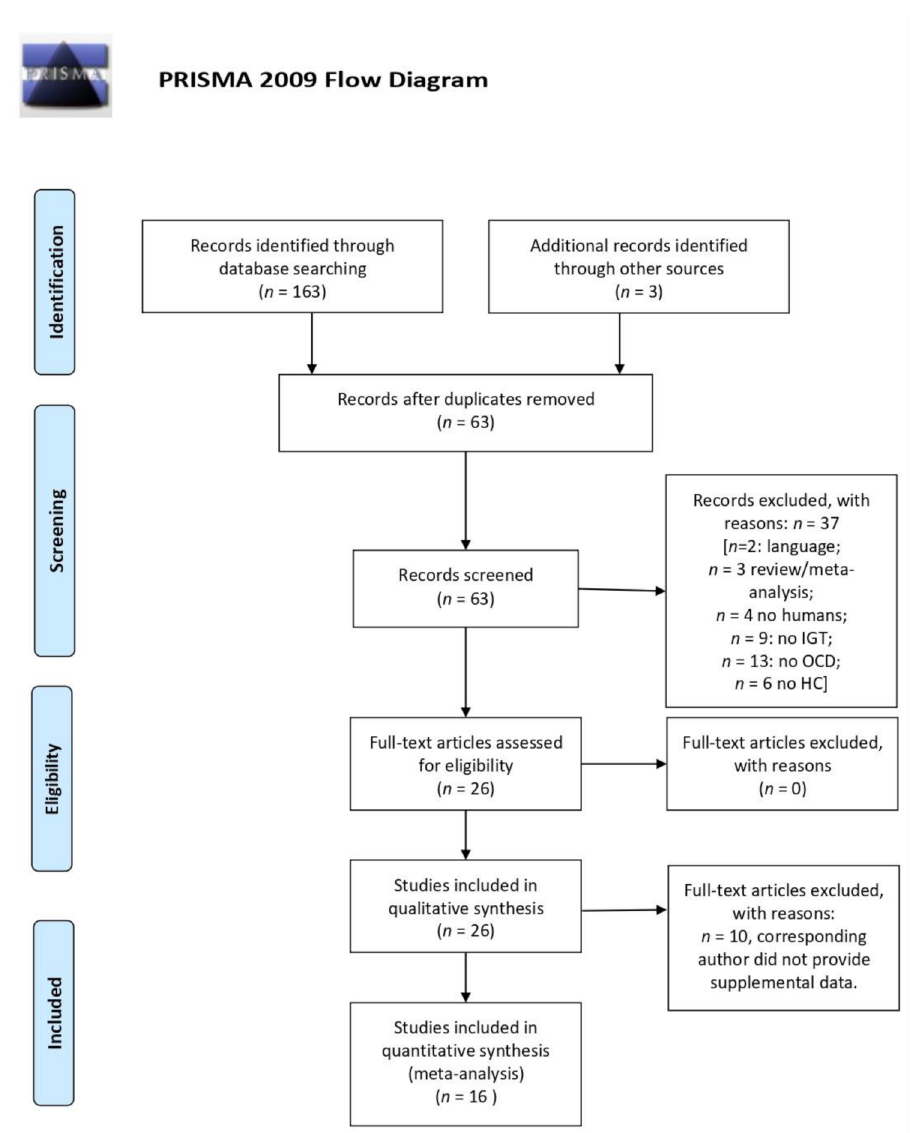
Figure 1. PRISMA flow diagram: Systematic Review and Meta-analysis